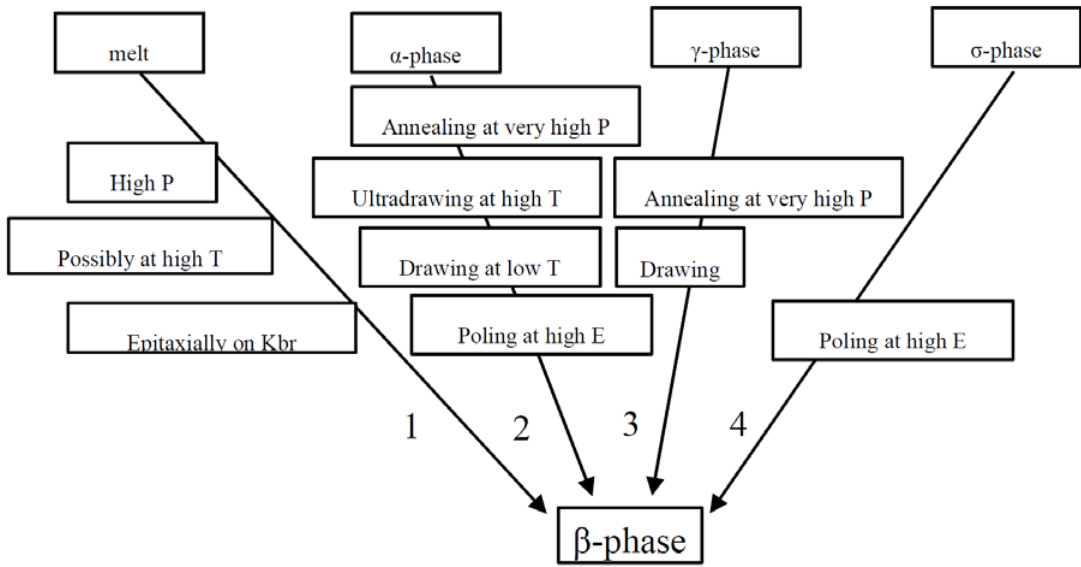
Figure 3. Four transition lines from different conformations to obtain β phase PVDF.